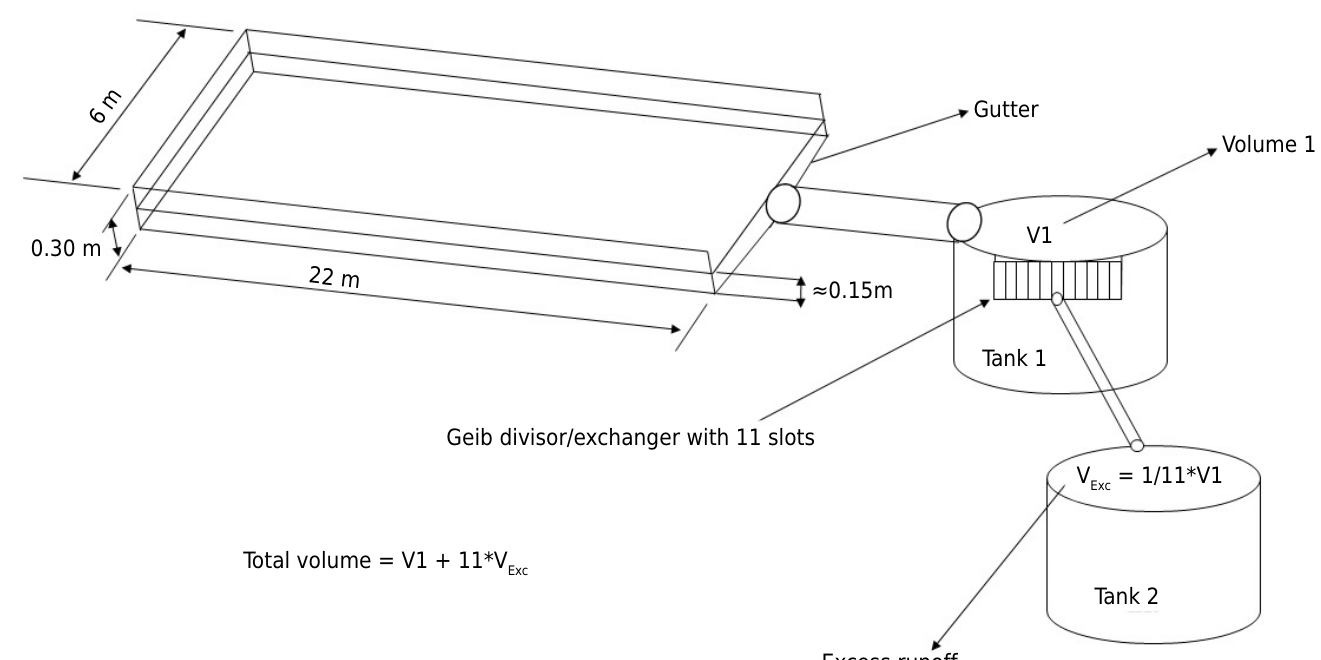
Figure 1. Experimental design of water and sediment collector